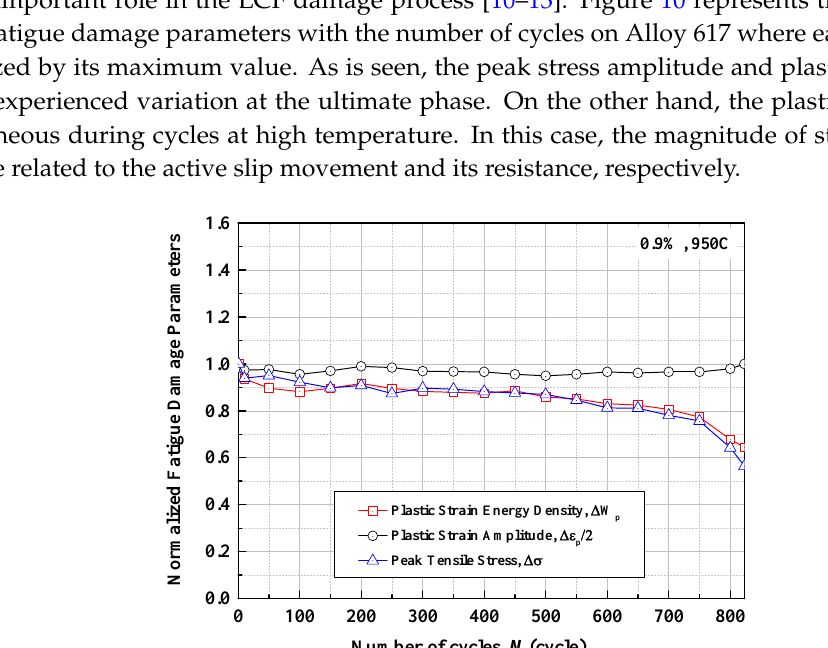
Figure 10. Evolutions of fatigue damage parameters: plastic strain energy absorbed per cycle, plastic strain amplitude, and peak tensile stress.